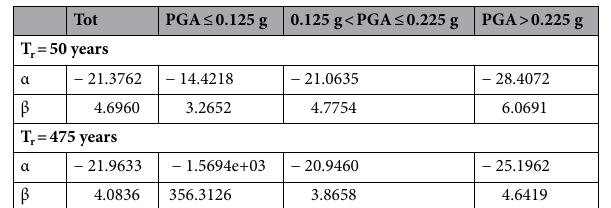
Table 3. Logistic regression coefficients for probability to cause exceedance of the design actions as a function of magnitude.